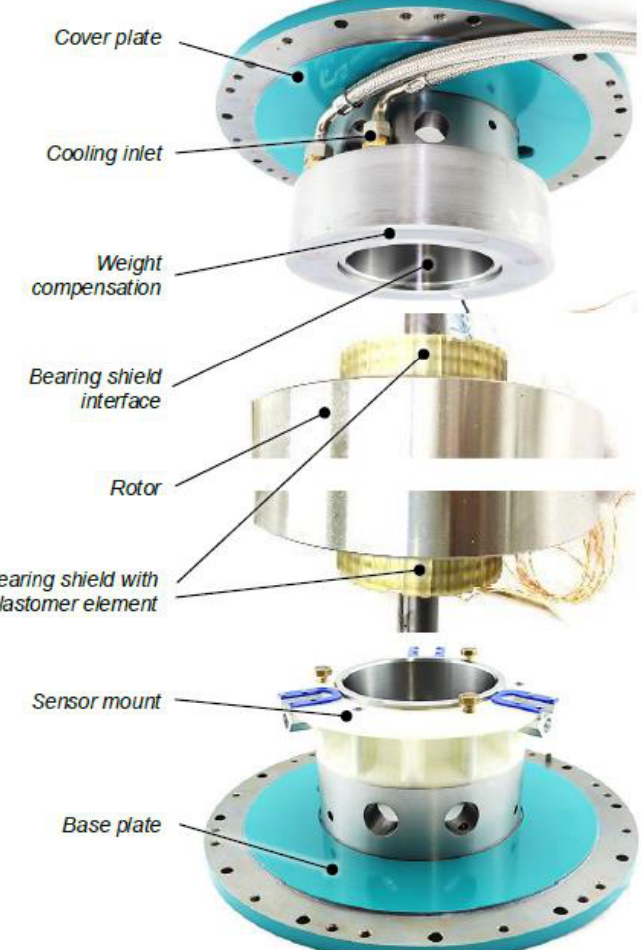
Figure 23. Rotor-bearing assembly of the flywheel.